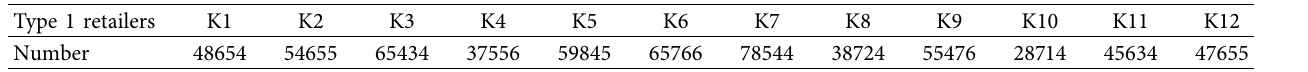
Table 4: The number of products sent to each type 1 retailer.